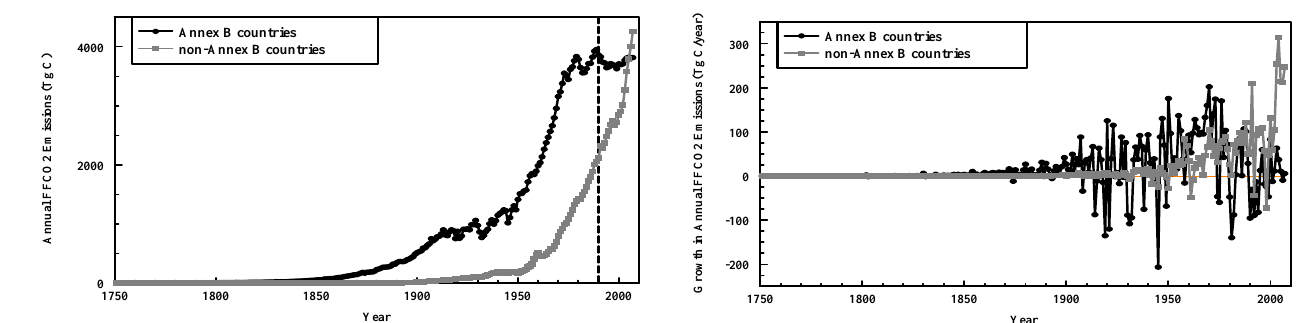
Fig. 3f. Growth of FFCO2 emissions from the year 1752 to 2007, disaggregated by Kyoto Protocol status. Similar to Figure 3b. Positive values indicate an increase in year-to-year emissions and negative values indicate a decrease in year-to-year emissions. An orange zero line has been added for reference. Data from Boden et al. (2010).